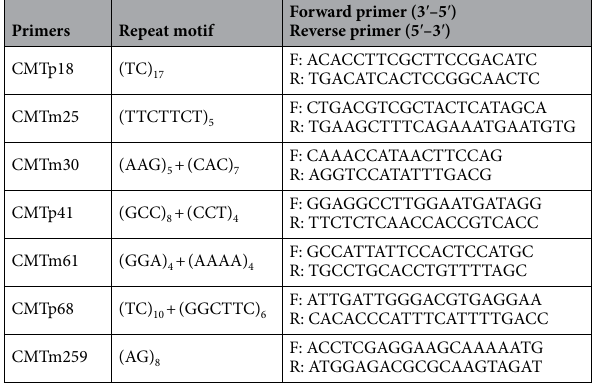
Table 2. Information on SSR